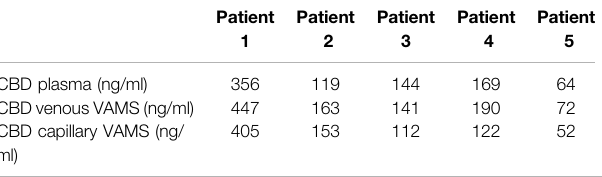
TABLE 2 | CBD therapeutic monitoring by VAMS and venipuncture including formulation and dose cannabis-based treatment.